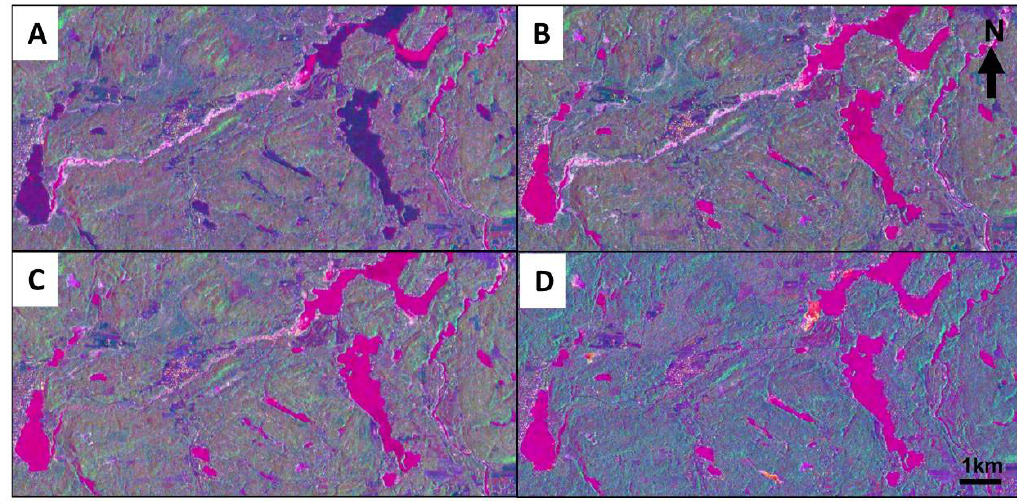
Figure 8. False colour composites of the processed Kennaugh elements, K 3 -K 0 -K 4 , from ( A ) 2 April, ( B ) 24 April, ( C ) 5 May, and ( D ) 18 June 2016. Open water appears in pink, ice in dark purple, flooded vegetation in white/light pink, and ‘other’ in green and blue.